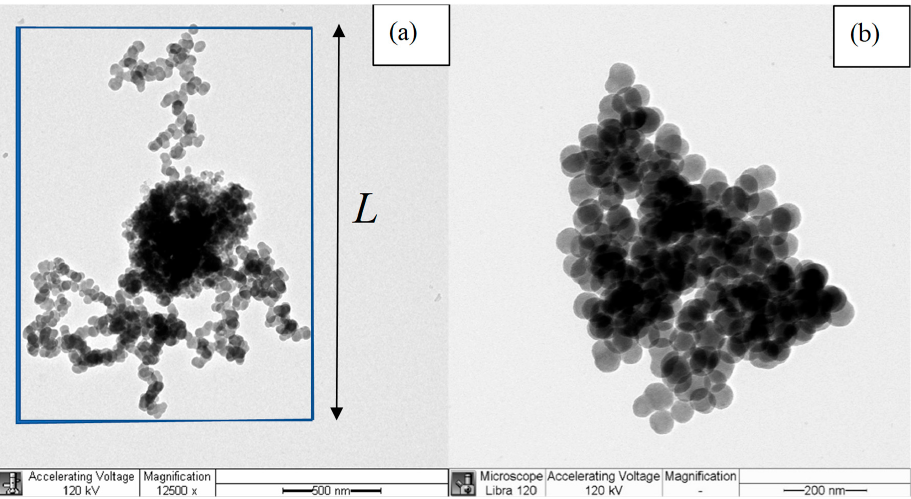
Figure 1. Examples of TEM images of biomass burning aerosol particles from ( a ) eucalyptus fuel and, ( b ) olive fuel.